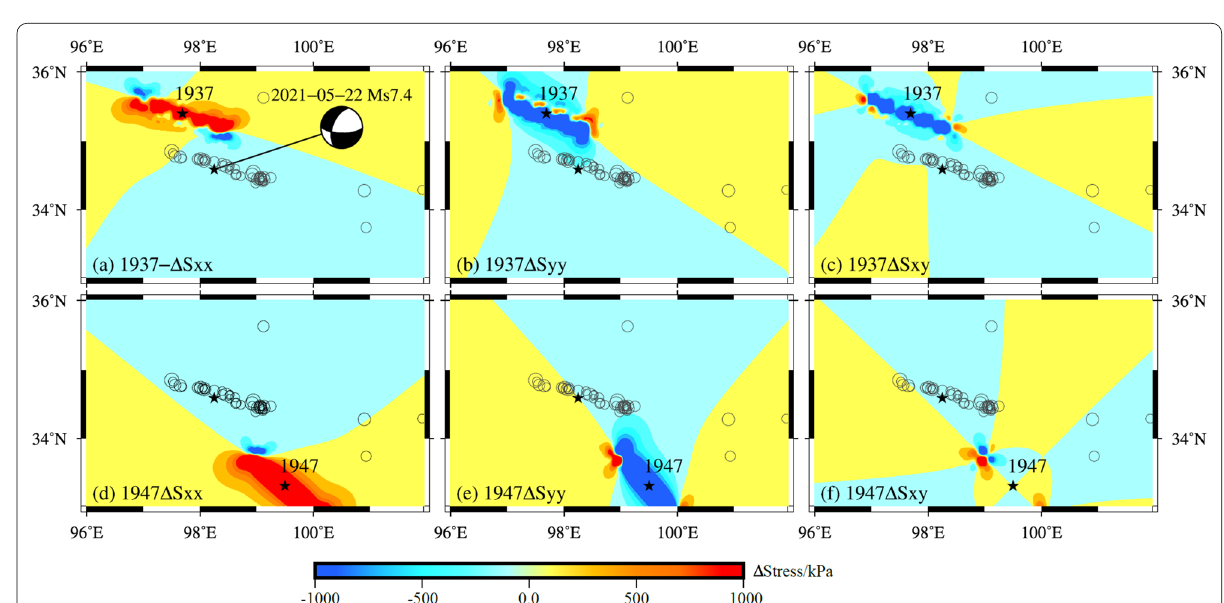
Fig. 3 Stress changes caused by the 1937 and 1947 earthquake. a – c are the ΔSxx, ΔSyy, and ΔSxy caused by 1937 earthquake, respectively; d – f are the ΔSxx, ΔSyy, and ΔSxy caused by 1947 earthquake, respectively; black beach ball shows the Maduo earthquake, black circles represent the aftershock of Maduo event, and black stars define the epicenter of the